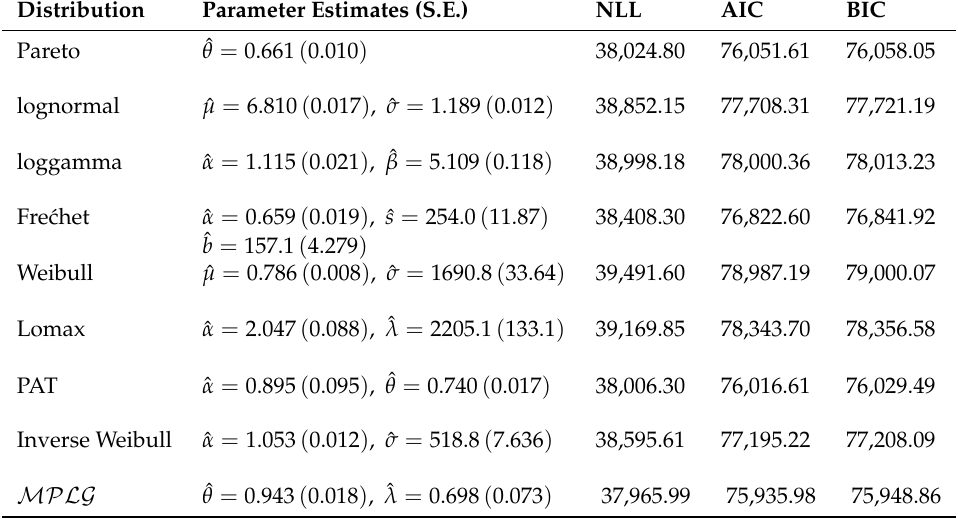
Table 1. Estimated values of different heavy-tailed models, corresponding standard errors (S.E.), negative of the log-likelihood function (NLL), Akaike’s information criterion (AIC) and Bayesian information criterion (BIC) for automobile claims dataset (De Jong and Heller